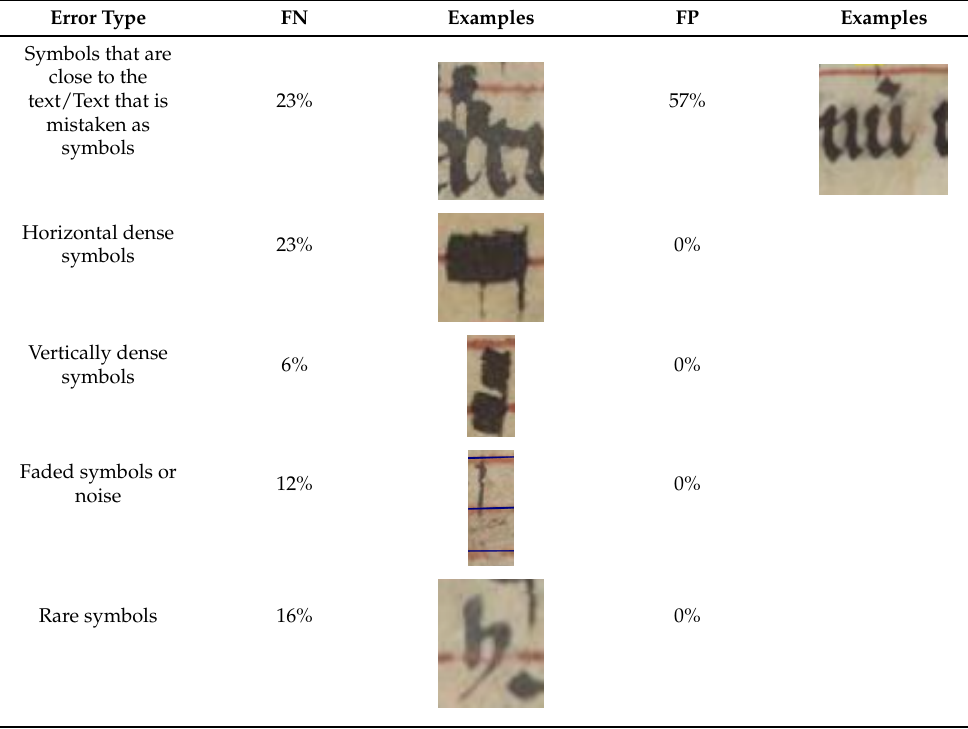
Table 10. Break down of FP and FN errors for additional and missing notes into several causes, which amount for 15.1% and 28.8% of the errors,